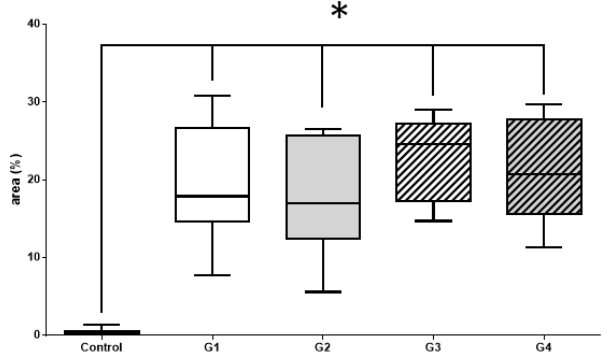
Figure 6. Histomorphometric analysis—Masson’s trichrome-Kruskal–Wallis statistical test with Dunn’s posttest. There was no significant statistical difference between the treated groups, but there was a statistically significant difference between the treated groups and the control group, which did not receive any type of treatment.